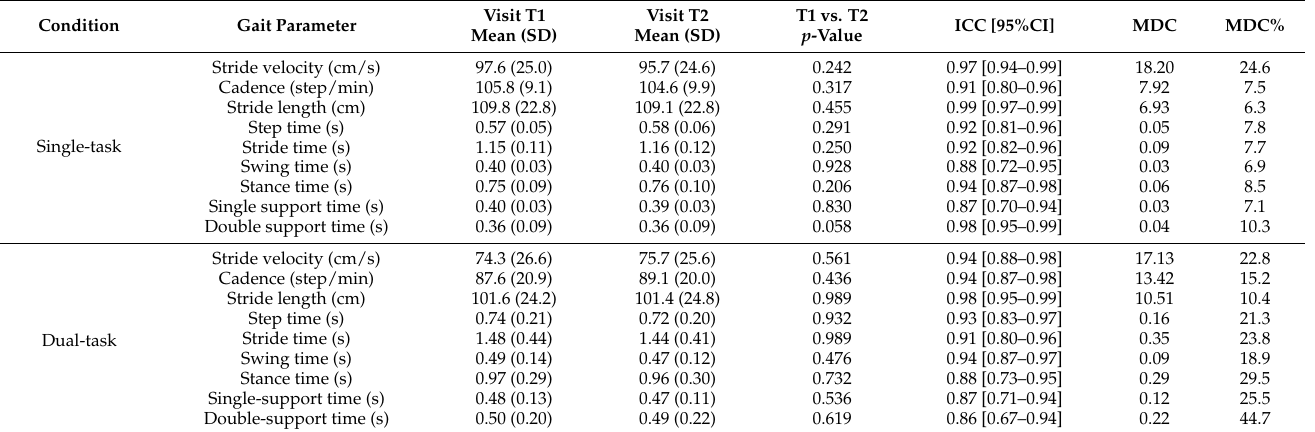
Table 3. Test–retest reliability of spatio-temporal parameters computed by the electronic walkway (reference system) during single and dual-tasking